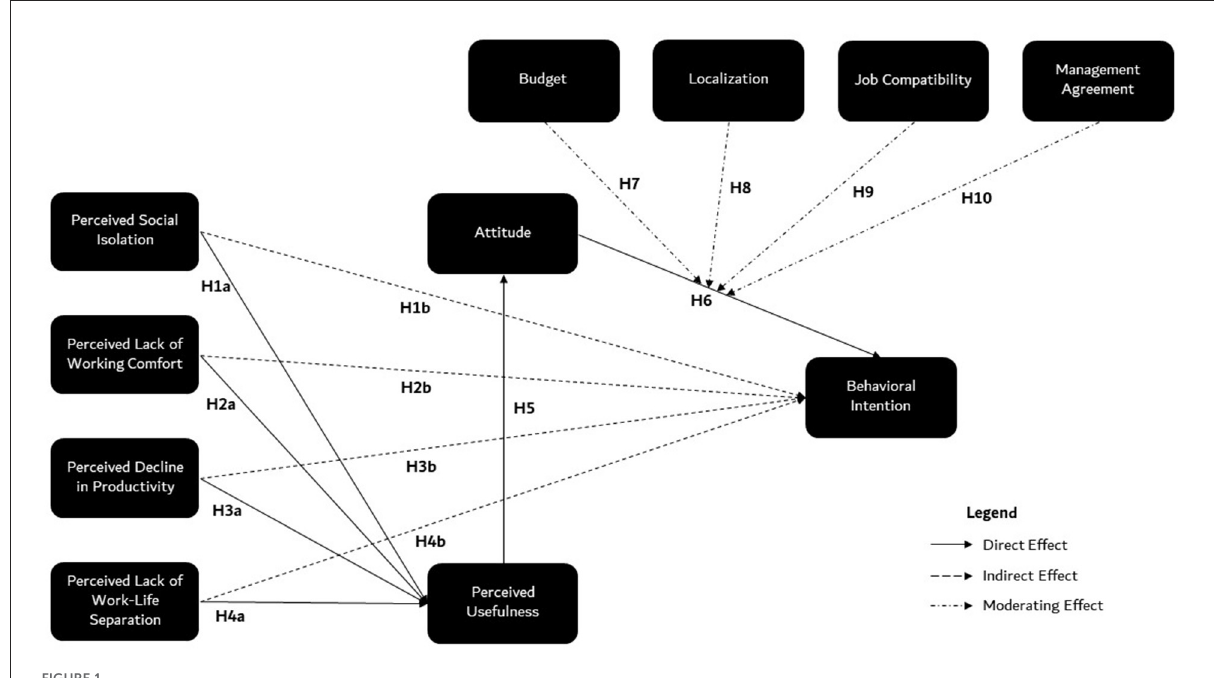
FIGURE1 Theoretical model of the expected